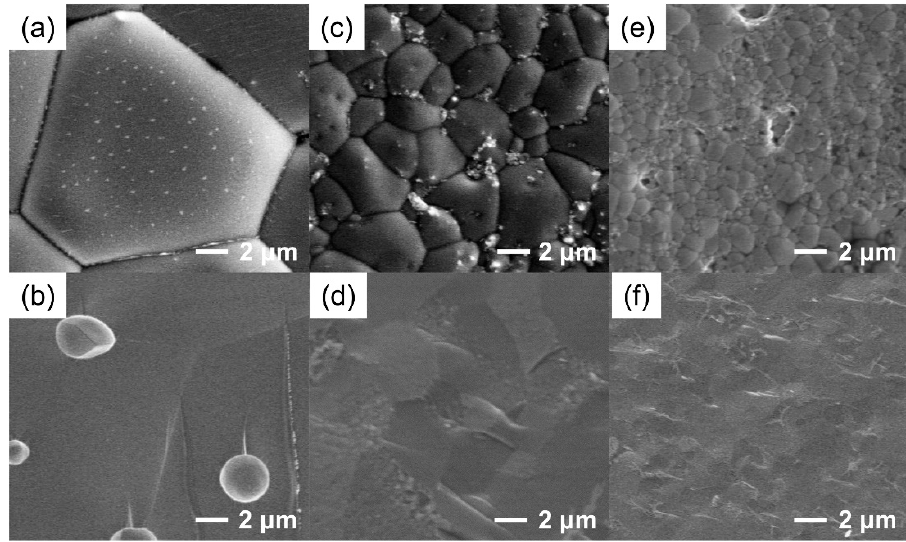
Figure 2. Surface and cross-sectional SEM images of as-prepared BCZY membranes: ( a , b ) BCZY1, ( c , d ) BCZY2 and ( e , f ) BCZY3.